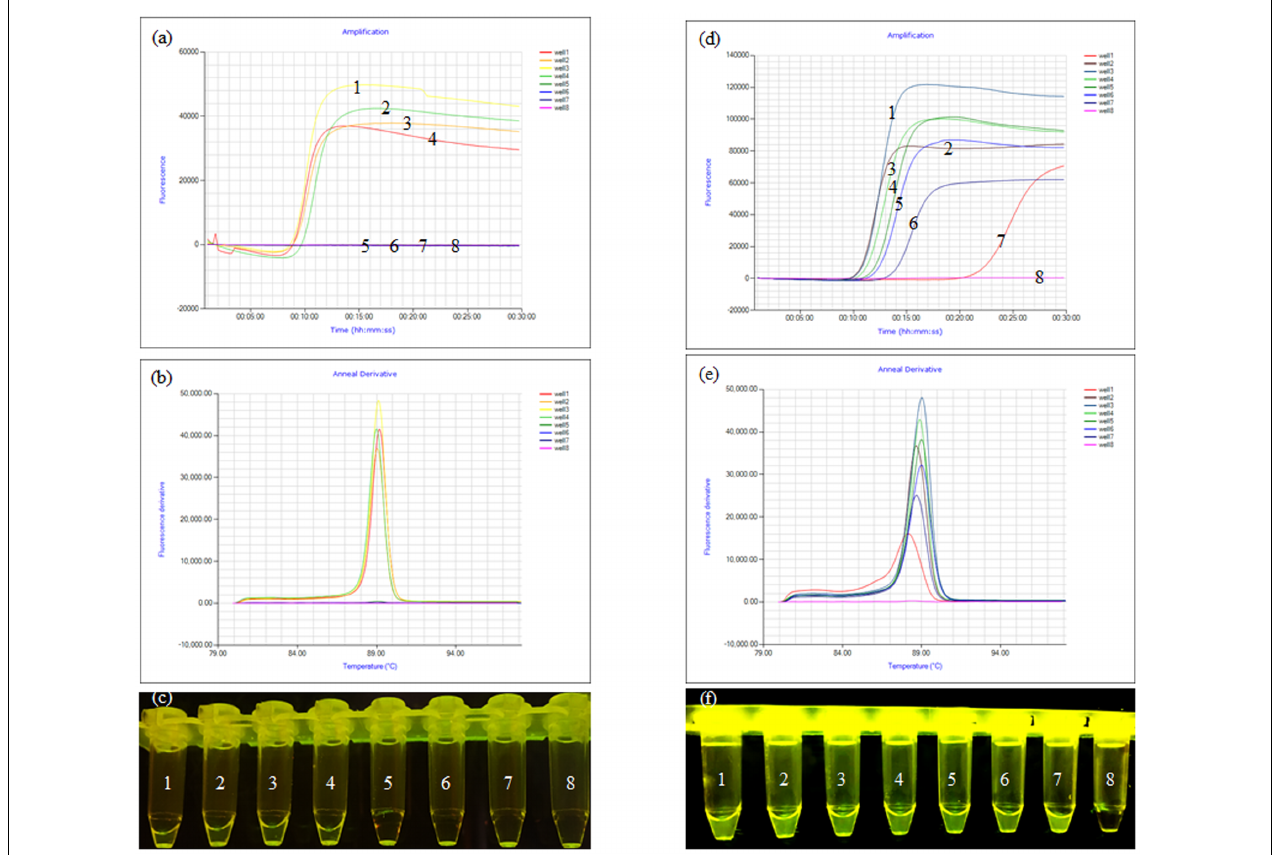
FIGURE 2 | Specificity and sensitivity of the ipaH -IC-LAMP assay. (a) Amplification curve of the specificity of IC-LAMP assays, (b) annealing curve of the specificity of IC-LAMP assays, (c) specificity of IC-LAMP assay observed under ultraviolet lamp; tubes 1, 2, 3, and 4 contained lysates of mixed bacteria with Shigella ( Escherichia coli , Shigella , Staphylococcus aureus , Salmonella , Listeria, and Pseudomonas aeruginosa ); tubes 5, 6, and 7 contained lysates of mixed bacteria without Shigella ( E. coli , S. aureus , Salmonella , Listeria , and P. aeruginosa ); tube 8 was a negative control. (d) Amplification curve of the sensitivity of IC-LAMP assays, (e) annealing curve of the sensitivity of IC-LAMP assays, (f) the sensitivity of the IC-LAMP assay as observed under ultraviolet lamp, tubes 1, 2, 3, 4, 5, 6, and 7 represent 8.7 × 10 6 , 8.7 × 10 5 , 8.7 × 10 4 , 8.7 × 10 3 , 8.7 × 10 2 , 8.7 × 10 1 , and 8.7 × 10 0 CFU/ml, respectively, and tube 8 was a negative control.